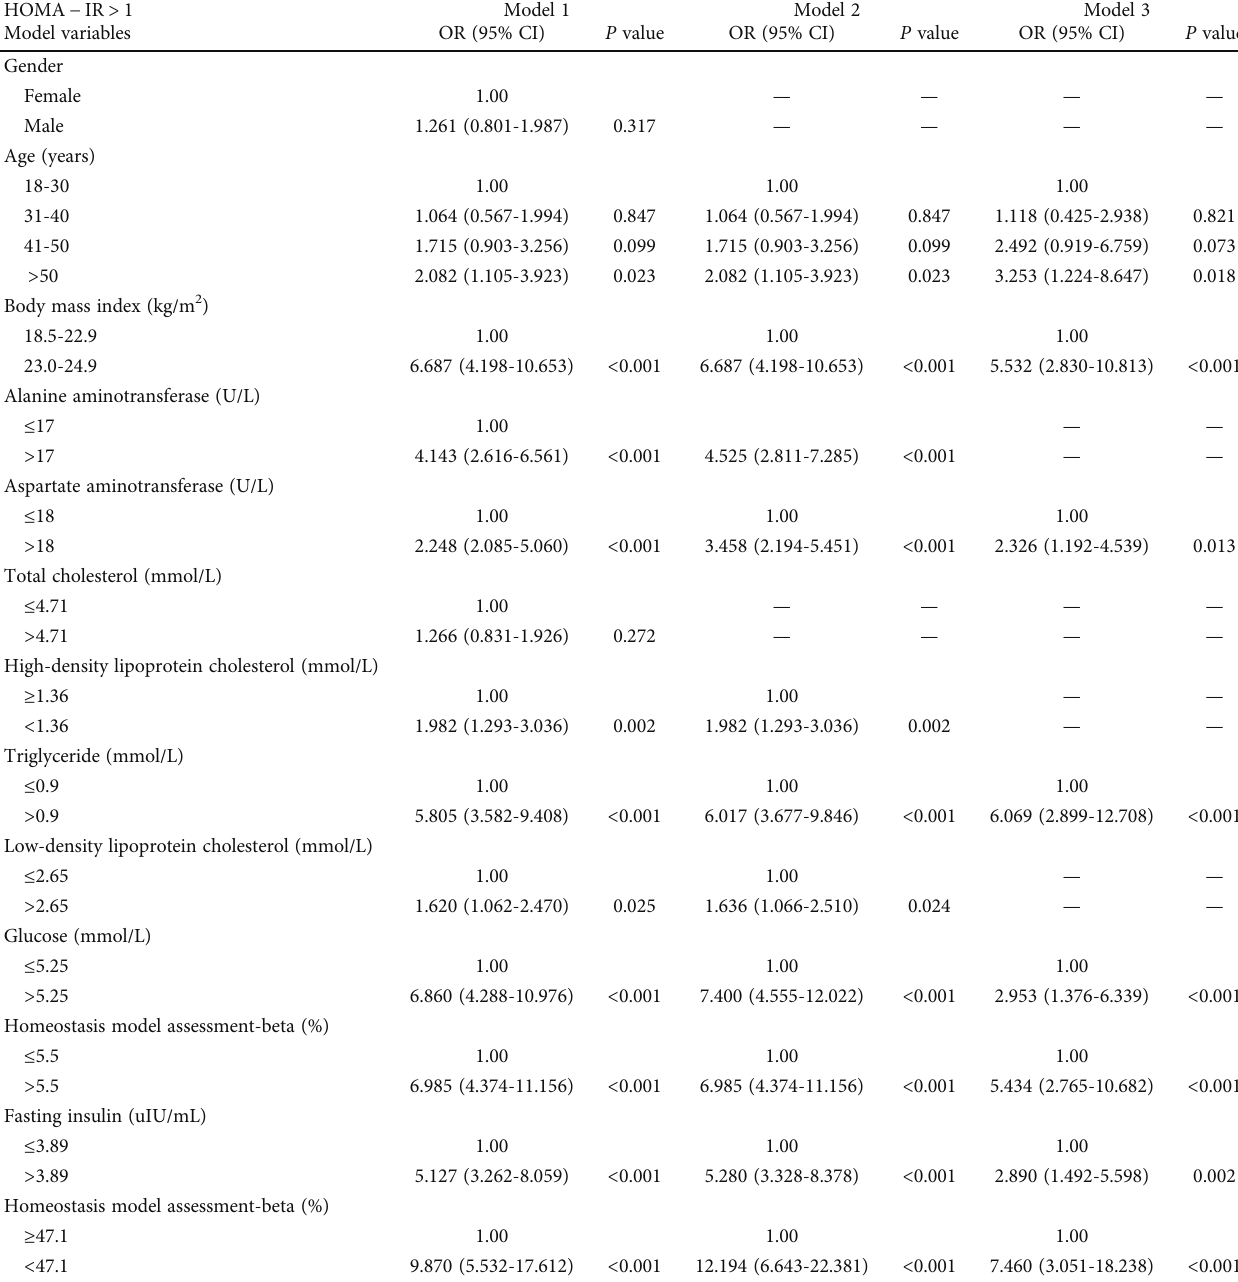
Table 2: Factors associated with the presence of nonobese NAFLD in the HOMA-IR > 1